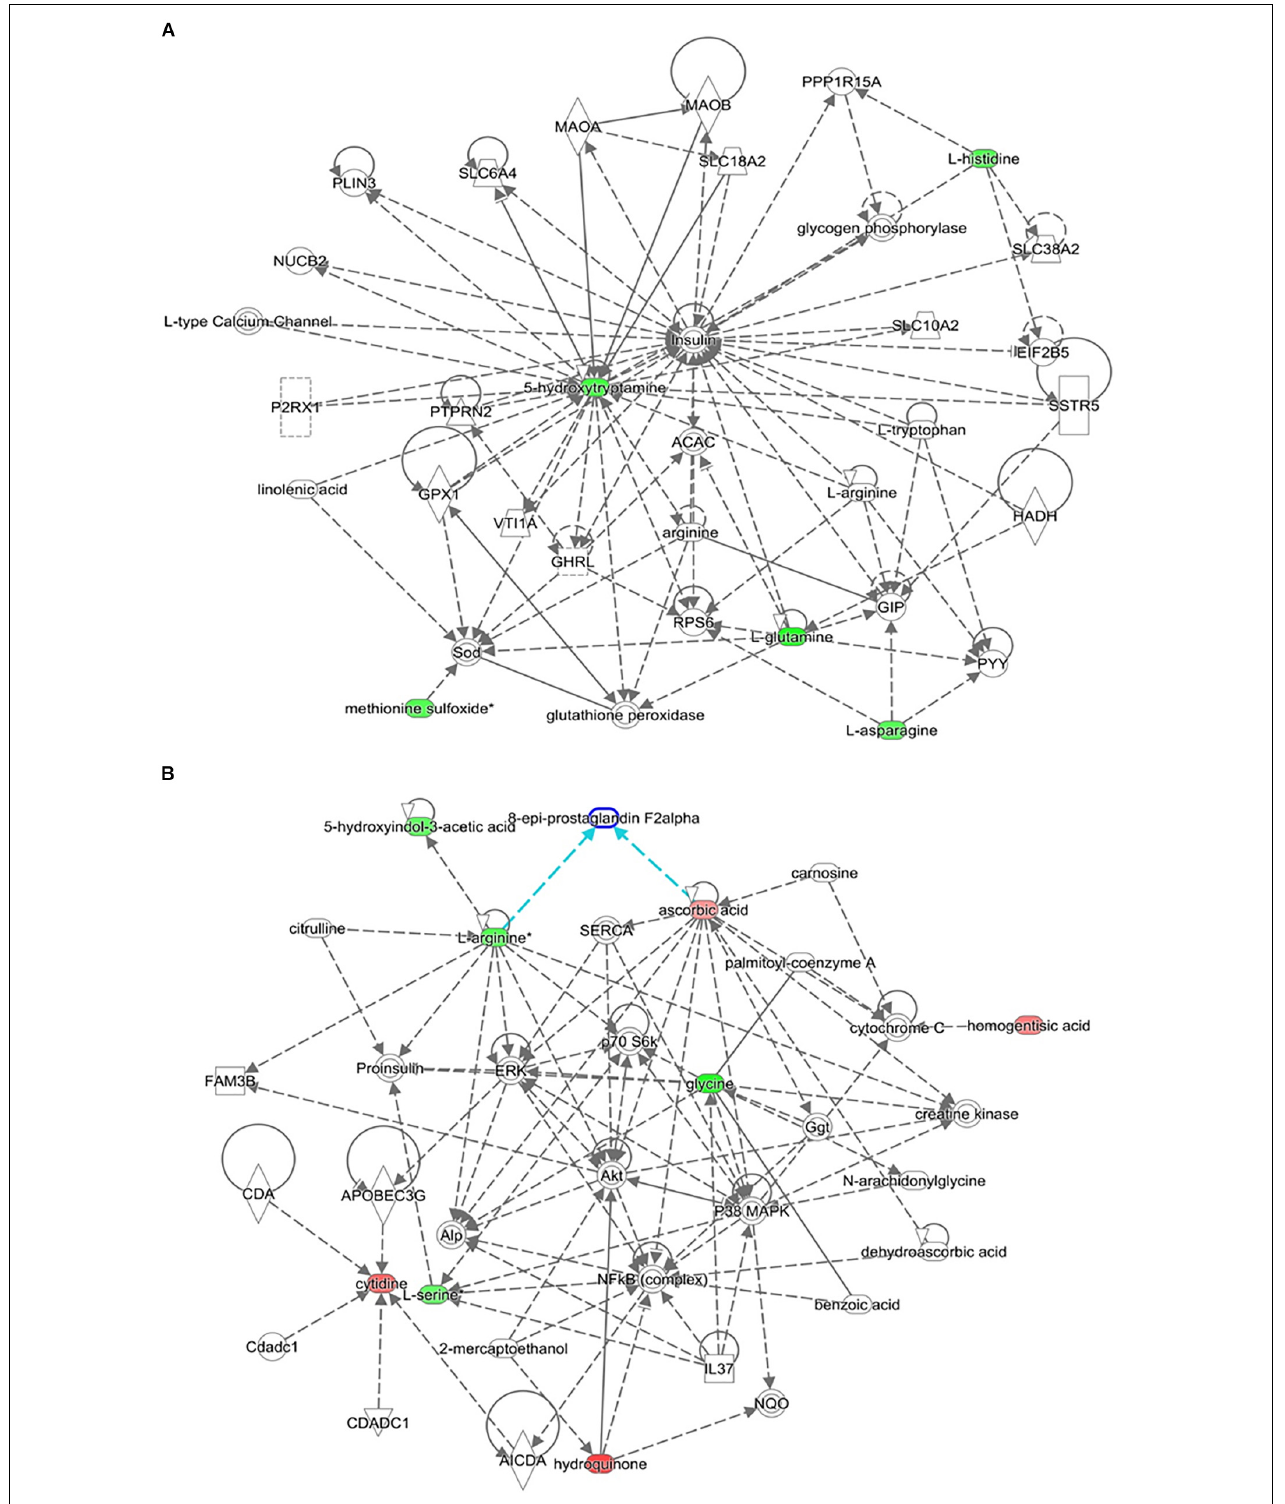
FIGURE 8 | Depicted top scoring I PA metabolomic networks. (A) “Cell-to-cell signaling and interaction, molecular transport, small molecule biochemistry“ for IR metabolomic panel and (B) “cellular compromise, lip id metabolism, small molecule biochemistry” for T2DM metabolomic panel. The dotted lines indicate indirect and the straight lines indicate direct relationships. Nodes colored red represent up-regulation and green represent down-regulation. The interaction networks were generated through the use of IPA (QIAGEN Inc., https://www.qiagenbioinformatics.com/products/ingenuity-pathway-analysis/).